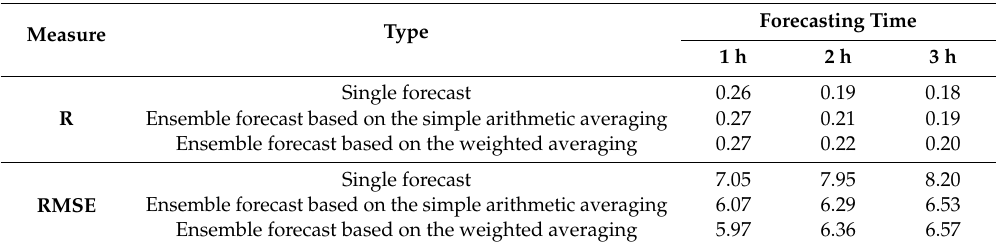
Table 4. Evaluation of the single forecast, the ensemble forecast based on the simple arithmetic averaging, and the ensemble forecast based on the weighted averaging at 10 target times. Measure